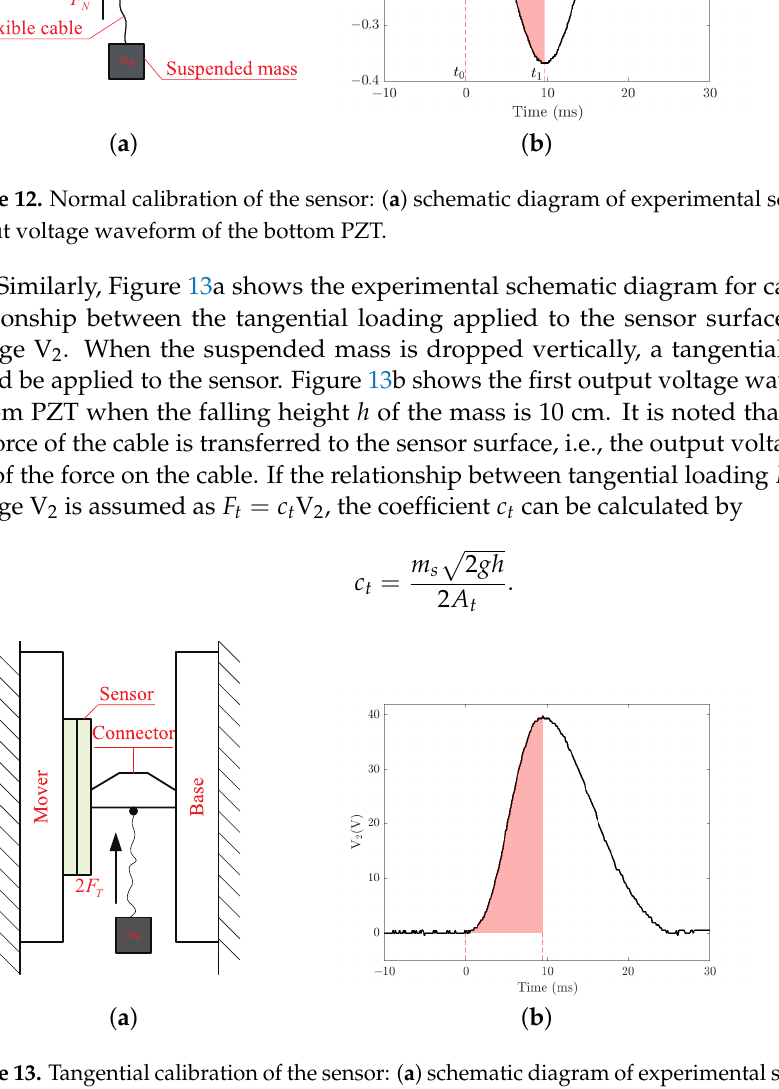
Figure 13. Tangential calibration of the sensor: ( a ) schematic diagram of experimental scheme; ( b ) first output voltage waveform of the top